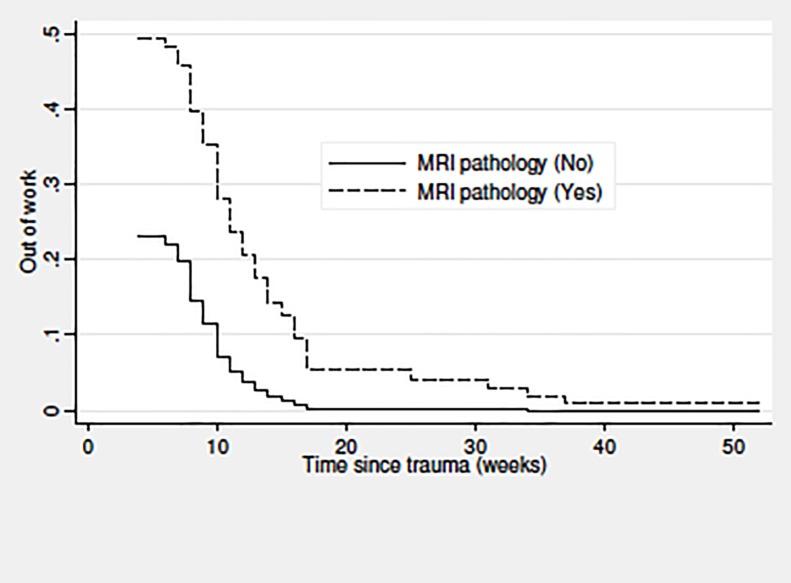
Time (weeks) until return to work for at least four weeks in relation to MRI findings among patients examined by early MRI on suspicion of scaphoid fracture (n = 125).Plot from multivariable Cox proportional hazard analyses; the Y-axis shows the probability (decimal numbers) of being out of work. Abbreviation: MRI = magnetic resonance imaging.